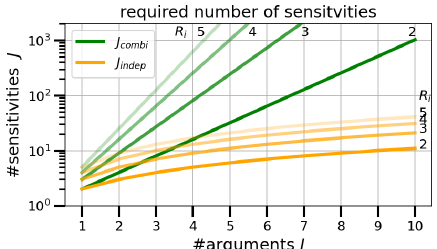
Figure 1. Number of required sensitivities as function of the num- ber of arguments I . Shown are the required numbers of com- bined ( J combi , Eq. 3, green) and independent ( J indep , Eq. 8, or- ange) sensitivities for different numbers of implementations R i = 2 , 3 , 4 , 5 ∀ i ∈ [ 1 ,I ]